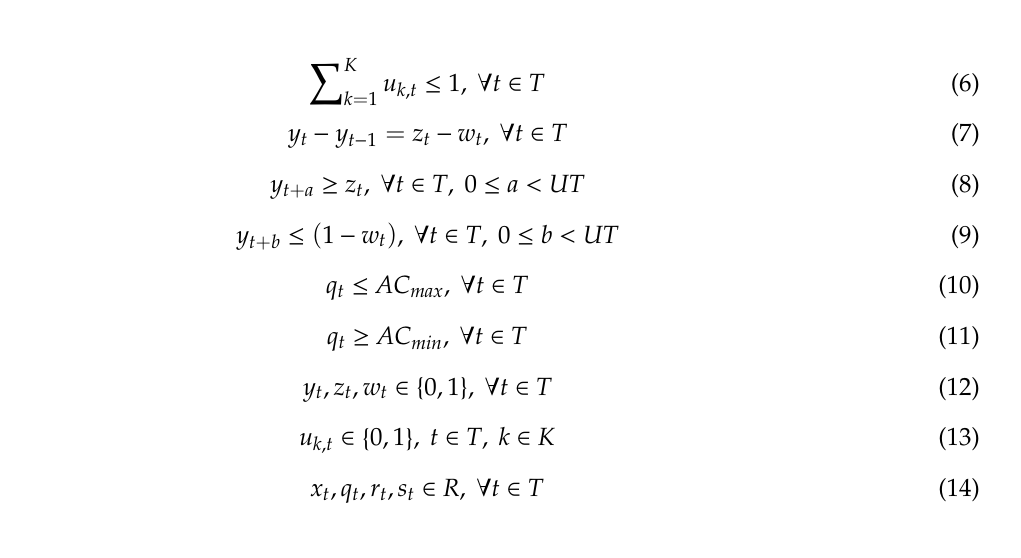
Table 1. Notations for Mathematical